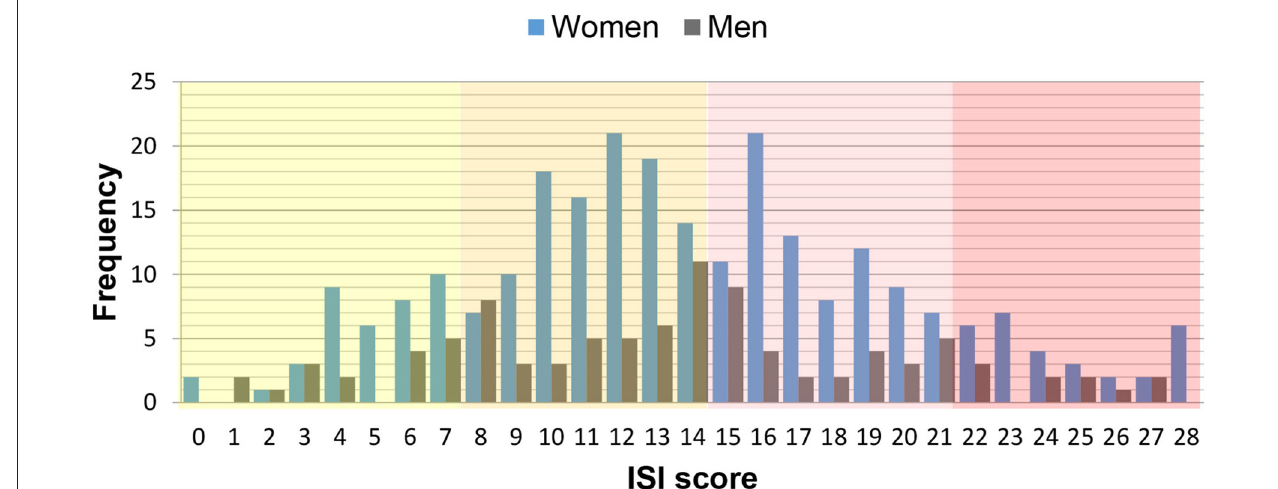
FIGURE 6 | Box plots representing the distribution of the Insomnia Severity Index (ISI) scores reported by patients experiencing insomnia by gender. Star symbol (*) indicates mean.